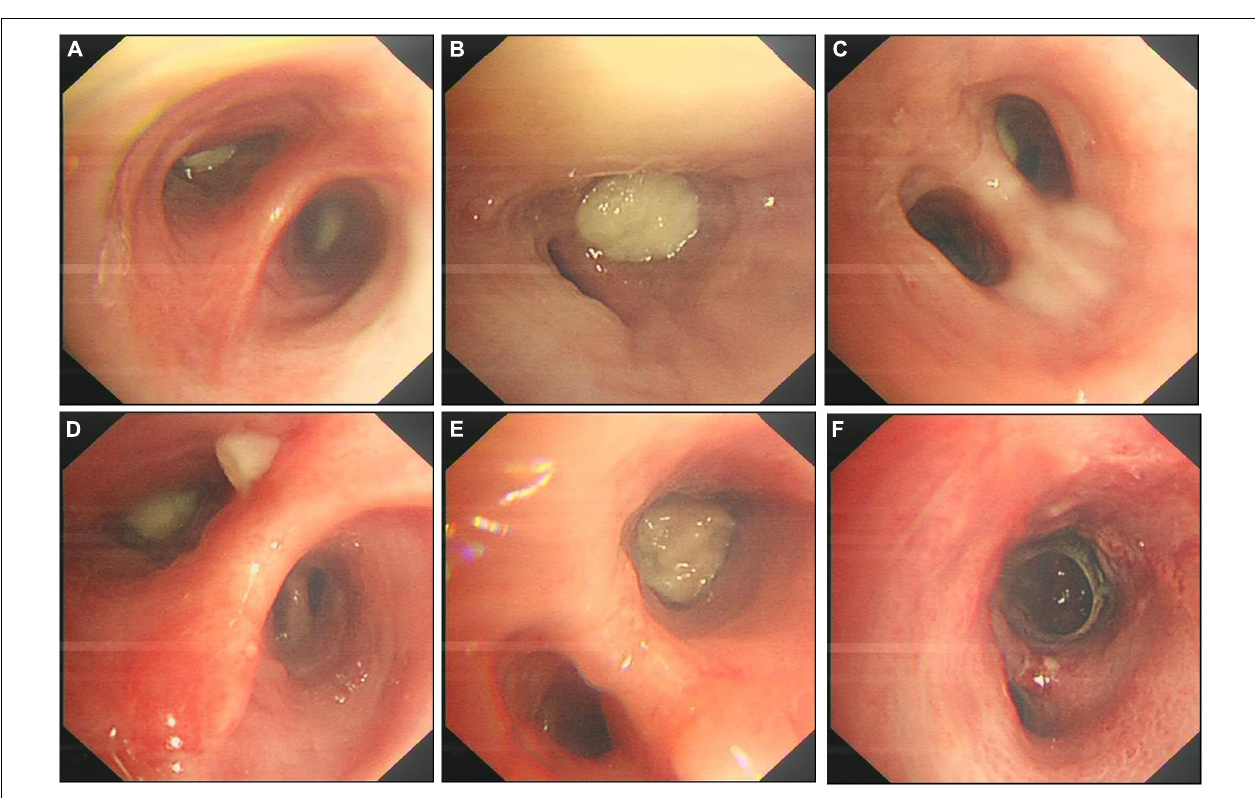
FIGURE 2 | A series of bronchoscopy images. The first bronchoscopy images (A–C) , the secondary bronchoscopy images (D–F) . (A) The medial and lateral segments of the RML were blocked by purulent yellow secretions. (B) The medial subsegment of the RML was completely obstructed by an endobronchial white necrotized mass. (C) The media subsegment of the RML became unobstructed after suction. (D) The medial and lateral segments of the RML were blocked by purulent yellow secretions. (E) The medial subsegment of the RML was completely obstructed by a an endobronchial white necrotized mass. (F) The media subsegment of the RML became unobstructed after suction. RML: Right middle